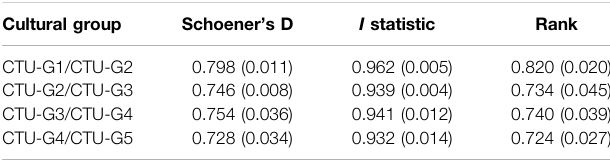
TABLE 8 | Schoener ’ s D, I statistic, and relative rank niche overlap statistics (0 = no overlap; 1 = perfect overlap) for consecutive CTU groups. Cultural group